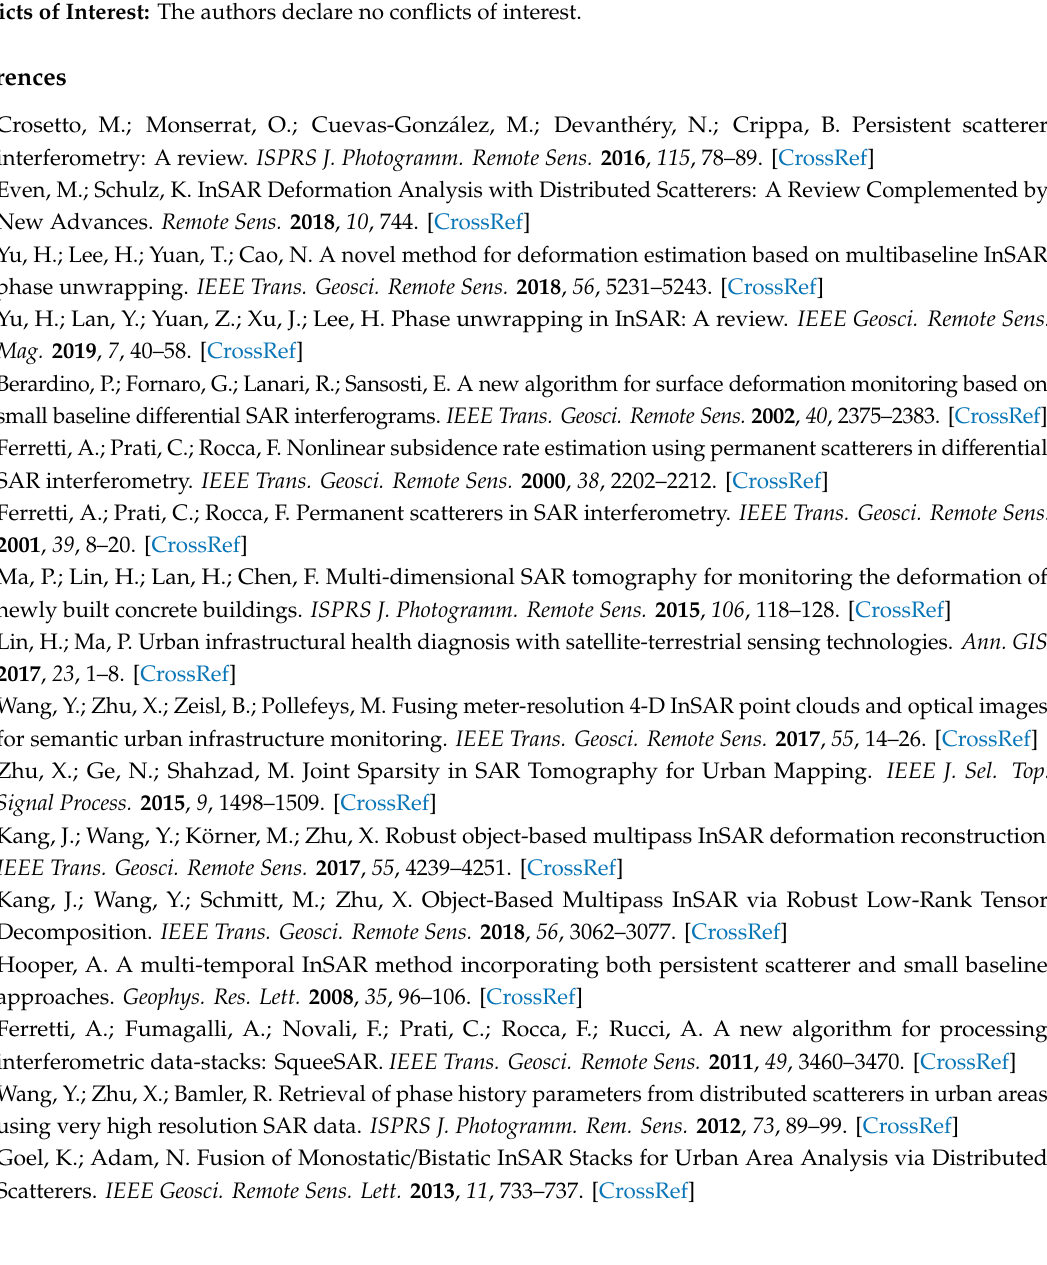
Figure S1: Comparison of execution time regarding pixel clustering and phase reconstruction; Figure S2: Mean (cid:12) (cid:12) (cid:12) (cid:12) values of (cid:12) φ (cid:12) and Cor for the HKIA case; Figures S3 and S4: PCPWPL applied to di ff erent bands and resolution SAR